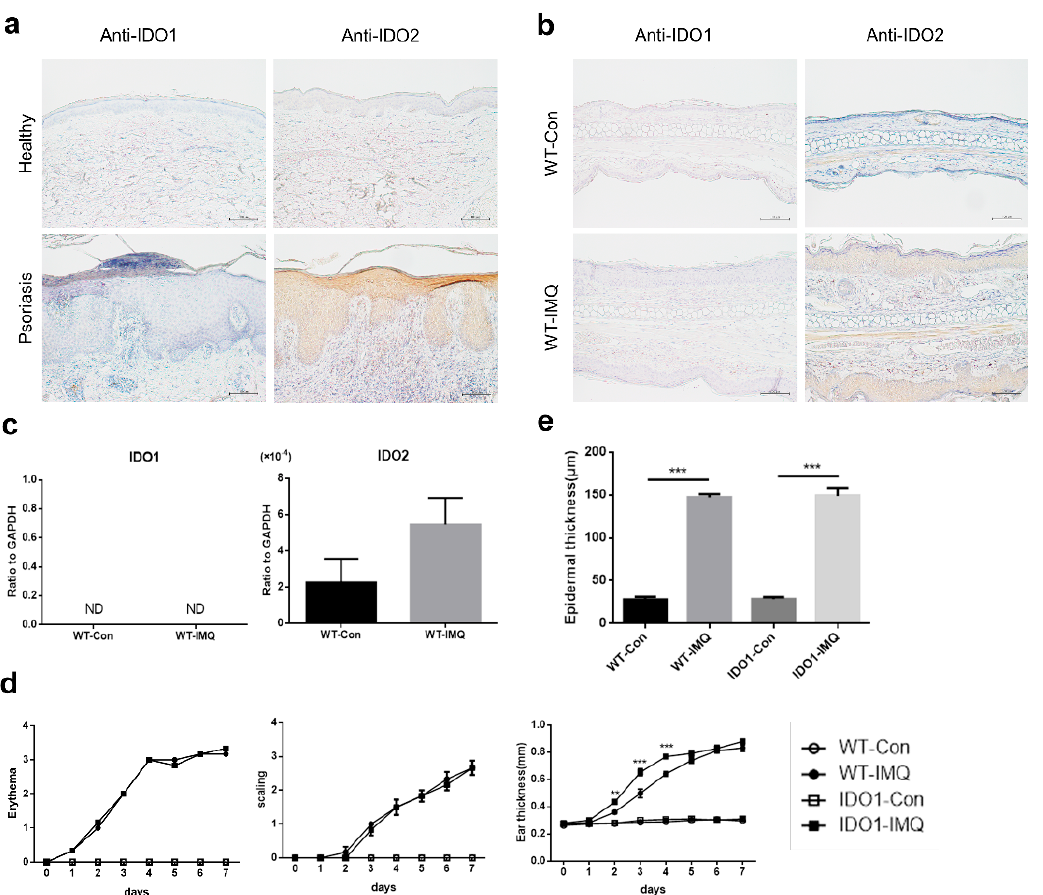
Figure 1. Psoriasiform lesions in the imiquimod-induced mouse model of psoriasis are associated with IDO2 but not with IDO1 . ( a ) Immunohistochemical staining of the skin from healthy volunteers and patients with psoriasis using antibodies to IDO1 and IDO2 . Scale bar = 100 µm. ( b ) Immunohistochemical staining of the ear from wild-type (WT) mice treated with vehicle or imiquimod (IMQ) for 7 days using antibodies to IDO1 and IDO2 . Scale bar = 100 µm. ( c ) The mRNA levels of IDO1 and IDO2 in the ears of WT mice treated with vehicle or IMQ for 7 days, detected using quantitative real-time PCR. Data are presented as mean ± SEM. (Student’s t -test). Control group, n = 6; IMQ-treated group, n = 9. ( d ) Erythema, scaling, and thickness of the ear in WT and IDO1 KO mice treated with vehicle or IMQ for 7 days were evaluated daily (0 = none, 1 = slight, 2 = moderate, 3 = marked, 4 = very marked). ** p < 0.01, *** p < 0.001 when comparing IDO1 KO-IMQ with WT-IMQ